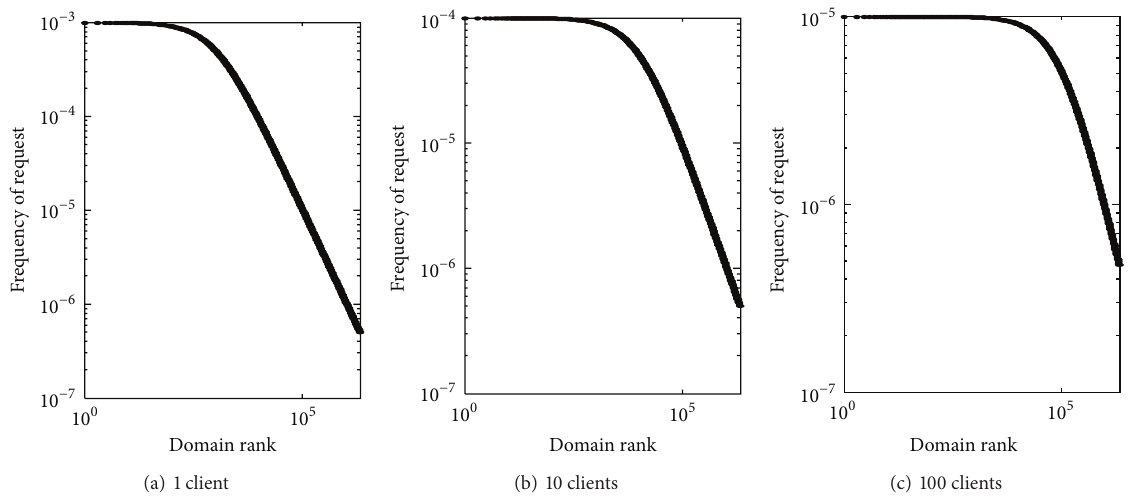
Figure 6: Caching sharing effects on the domain name